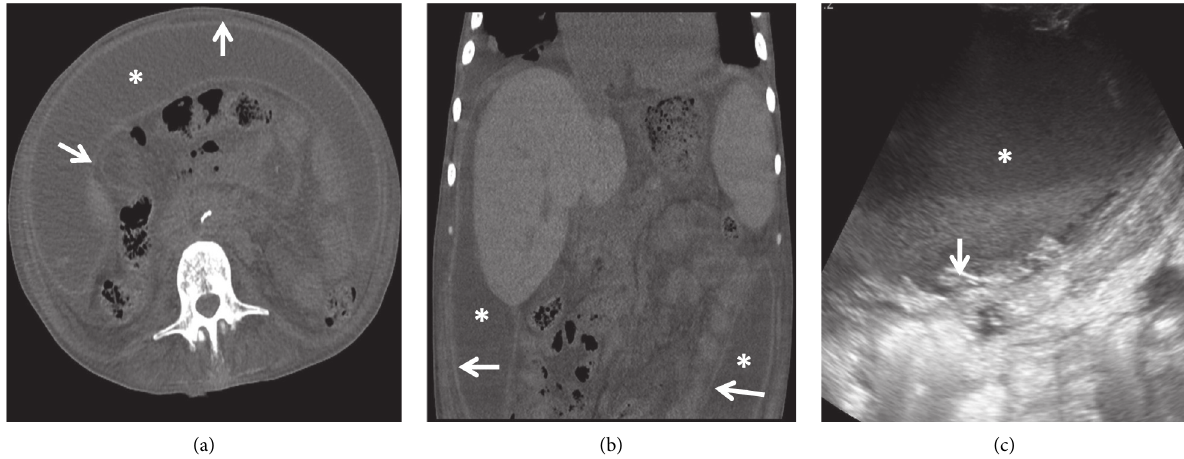
Figure 1: A 52-year-old male with sclerosing encapsulating peritonitis. (a) Axial noncontrast CT of the abdomen showing encapsulated ascites ( ∗ ) within the thickened layers of the peritoneum (arrows). The bowel loops are displaced centrally due to the mass effect. (b) Coronal noncontrast CT image shows the extent of the encapsulated fluid ( ∗ ) within the thickened peritoneum (arrows). (c) Grayscale ultrasound image acquired just prior to the paracentesis shows a low level of homogenous echotexture of the ascitic fluid ( ∗ ) and encapsulating thickened peritoneum